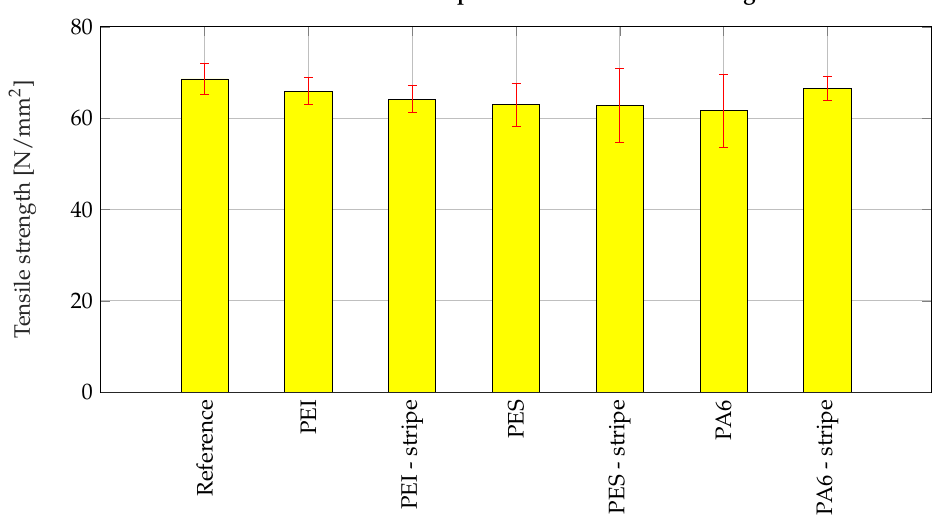
Figure 7. Influence of thermoplastic films and sensor edges on the tensile strength perpendicular to the